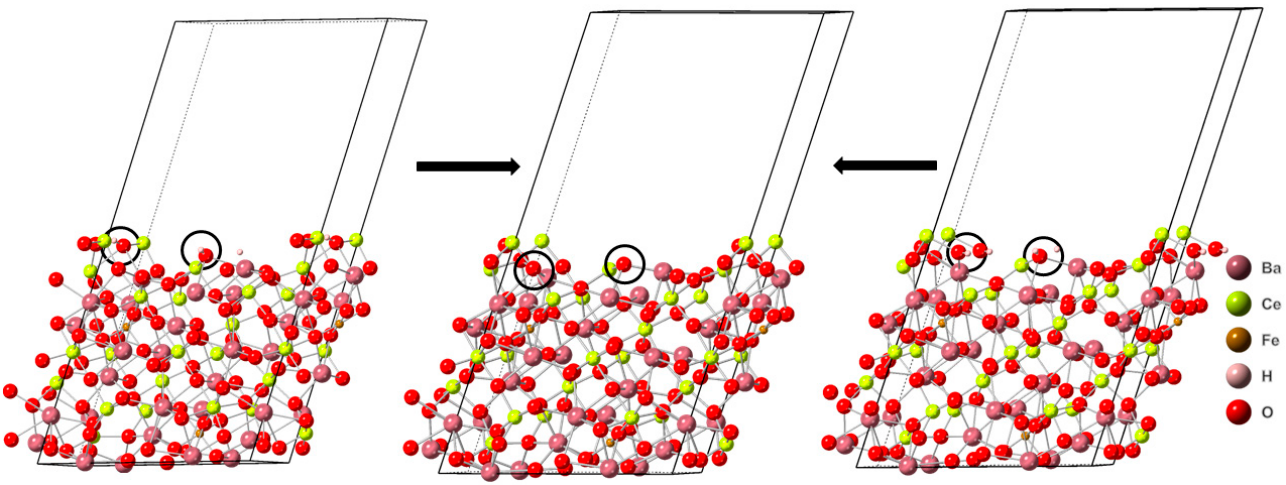
Figure 6. The reaction sites are indicated by black circles. The lefthand structure stoichiometry is Ba 16 Ce 14 Fe 2 H 2 O 47 . The righthand structure stoichiometry is Ba 16 Ce 14 Fe 2 H 2 O 46 . The center structure stoichiometry is Ba 16 Ce 14 Fe 2 O 46 . Images generated using CrystalMaker ® , CrystalMaker Software Ltd., (Oxford, England), (www.crystalmaker.com accessed on 26 December